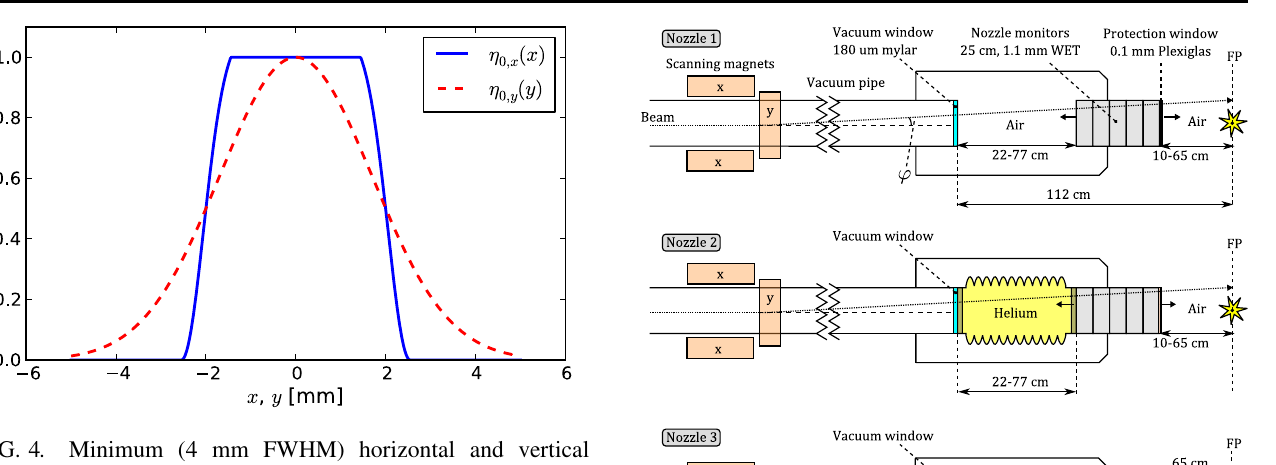
shifter.FIG. 4. Minimum (4 mm FWHM) horizontal and vertical pristine beam profiles at the focal point.